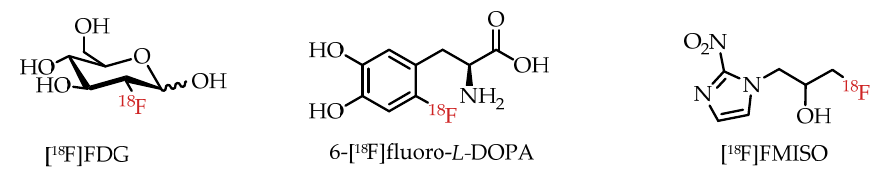
Figure 3. Prominent examples of clinically used fluorine ‐ 18 ‐ labelled PET